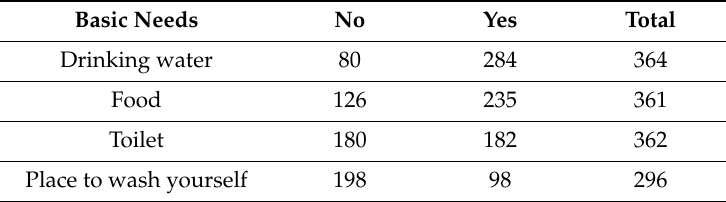
Table 5. Access to basic amenities on the landfills.